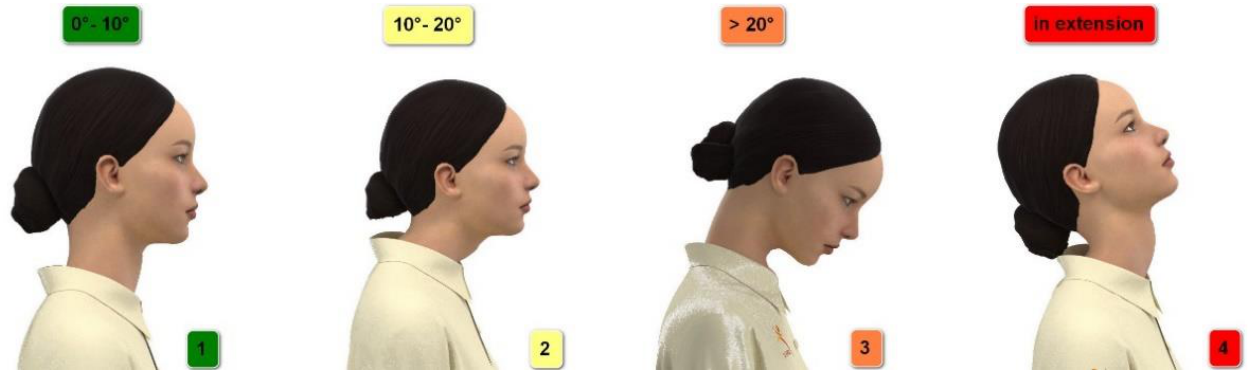
Figure 1. Neck positions with the score points for the angle of flexion or extension.